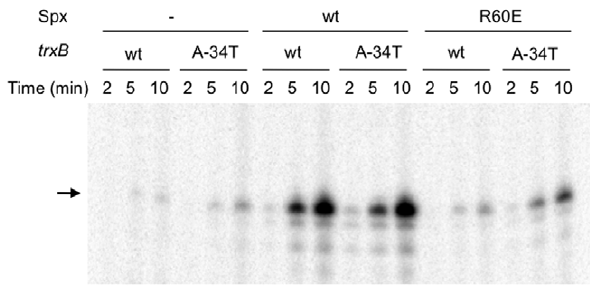
and R60E Spx. Either the wild-type or A-34T trxB template (1 nM) was incubated with 25 nM RNAP together with 25 nM s A in the presence of 7.5 nM Spx. The arrow shows the 66-base trxB transcript.